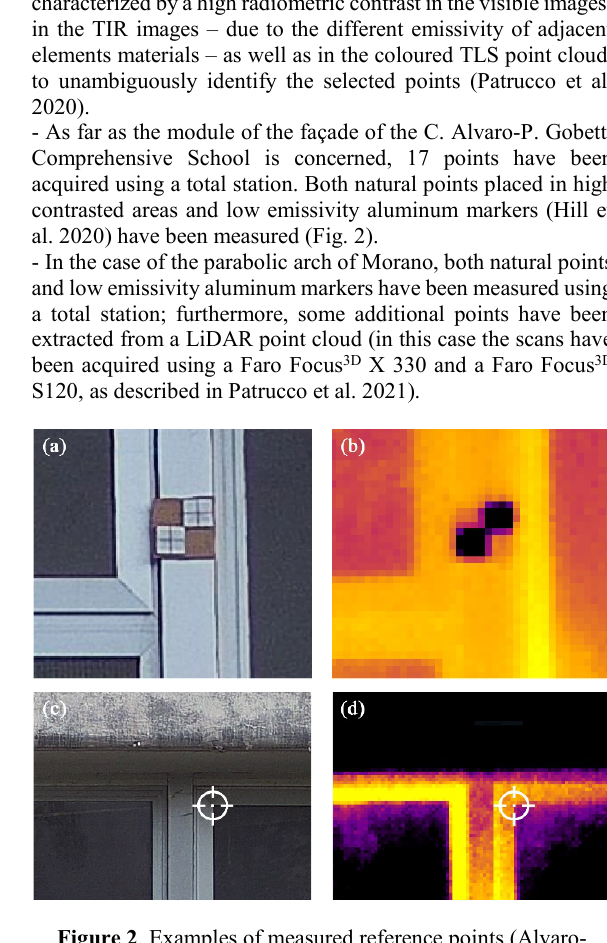
Figure 2 . Examples of measured reference points (Alvaro- Gobetti school dataset). Low emissivity target (aluminium): (a) visible image; (b) thermal image. Natural points: (a) visible image; (b) thermal image.